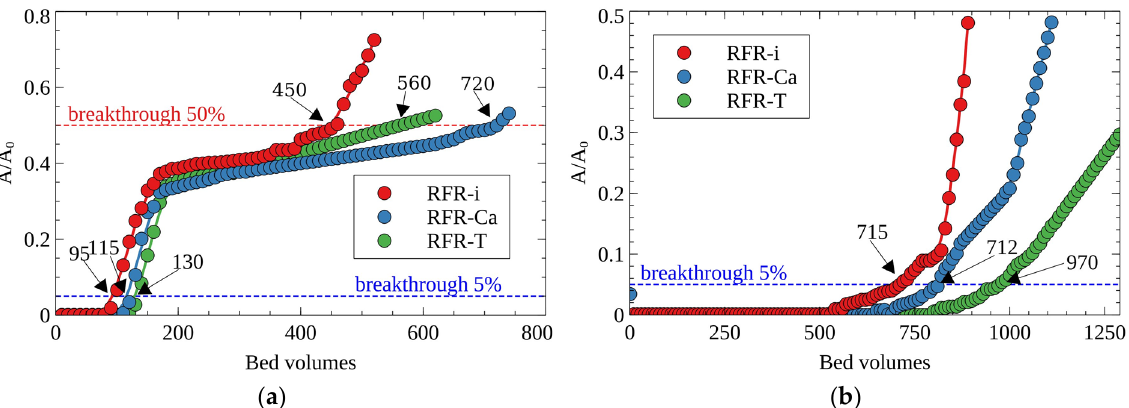
Figure 10. Breakthrough curves of cesium sorption from CP-HLW (see Table 7): ( a ) Cs-137 + 133 (0.05 g/L), ( b ) Cs-137, grain size—0.1–0.2 mm, solution flow rate—25 BV/h.